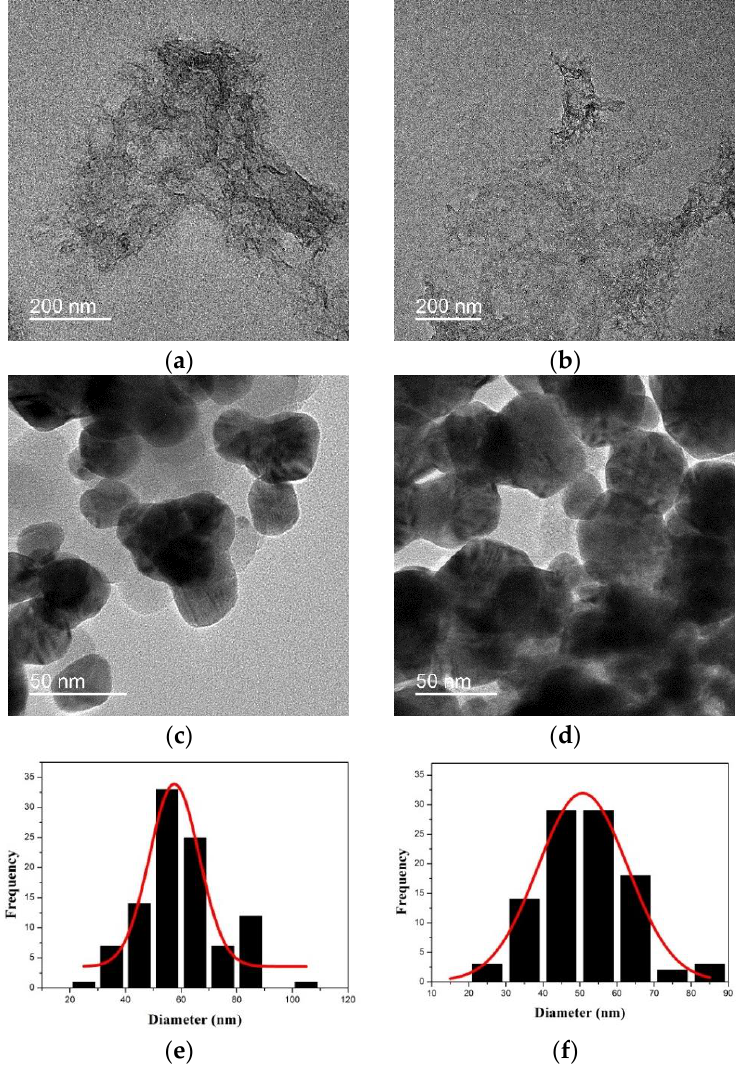
Figure 2. High resolution TEM images of ( a ) graphene oxide; ( b ) thiolated thin silica-coated graphene oxide; ( c ) silver nanoparticle-embedded silica-coated graphene oxide GO@SiO 2 @Ag NPs; and ( d ) silver nanoparticle-embedded graphene oxide (GO@Ag NPs); histograms of ( e ) silver nanoparticle-embedded silica-coated graphene oxide and ( f ) silver nanoparticle-embedded graphene oxide.